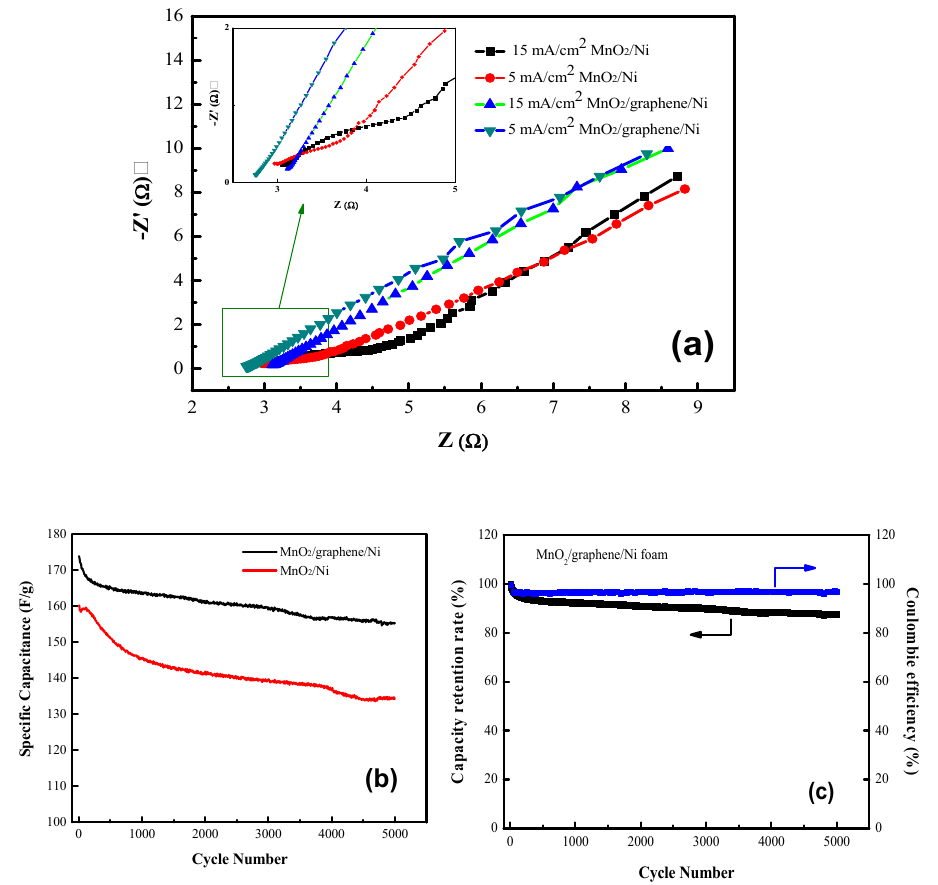
Figure 5. Nyquist plots of the electrodes ( a ), the cycling characteristics of the two electrodes under the current density of 5 A g − 1 ( b ), and the coulombic efficiency of the MnO 2 /graphene/Ni electrode ( c ). Table 2. The impedance value of MnO 2 /Ni and MnO 2 /graphene/Ni electrodes. Samples